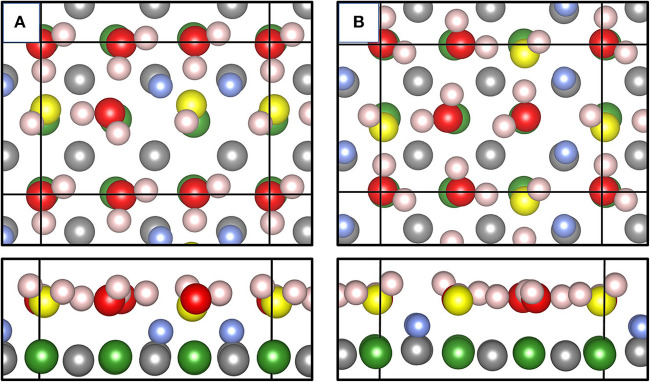
Top and side views of the adsorbate layer consisting of 6 H2O molecules on a p(3 × 2) MgO(001) surface generated via MD simulation at 400 K and optimized using PBE (A). Top and side views of the global energy minimum structure published in literature (Wlodarczyk et al., 2011) (B). Color code: Mg ions are green, H in surface OH is blue, O in intact H2O molecules is red, O in terminal, 1-coordinated OH atop Mg ions are yellow, and surface O ions are gray.